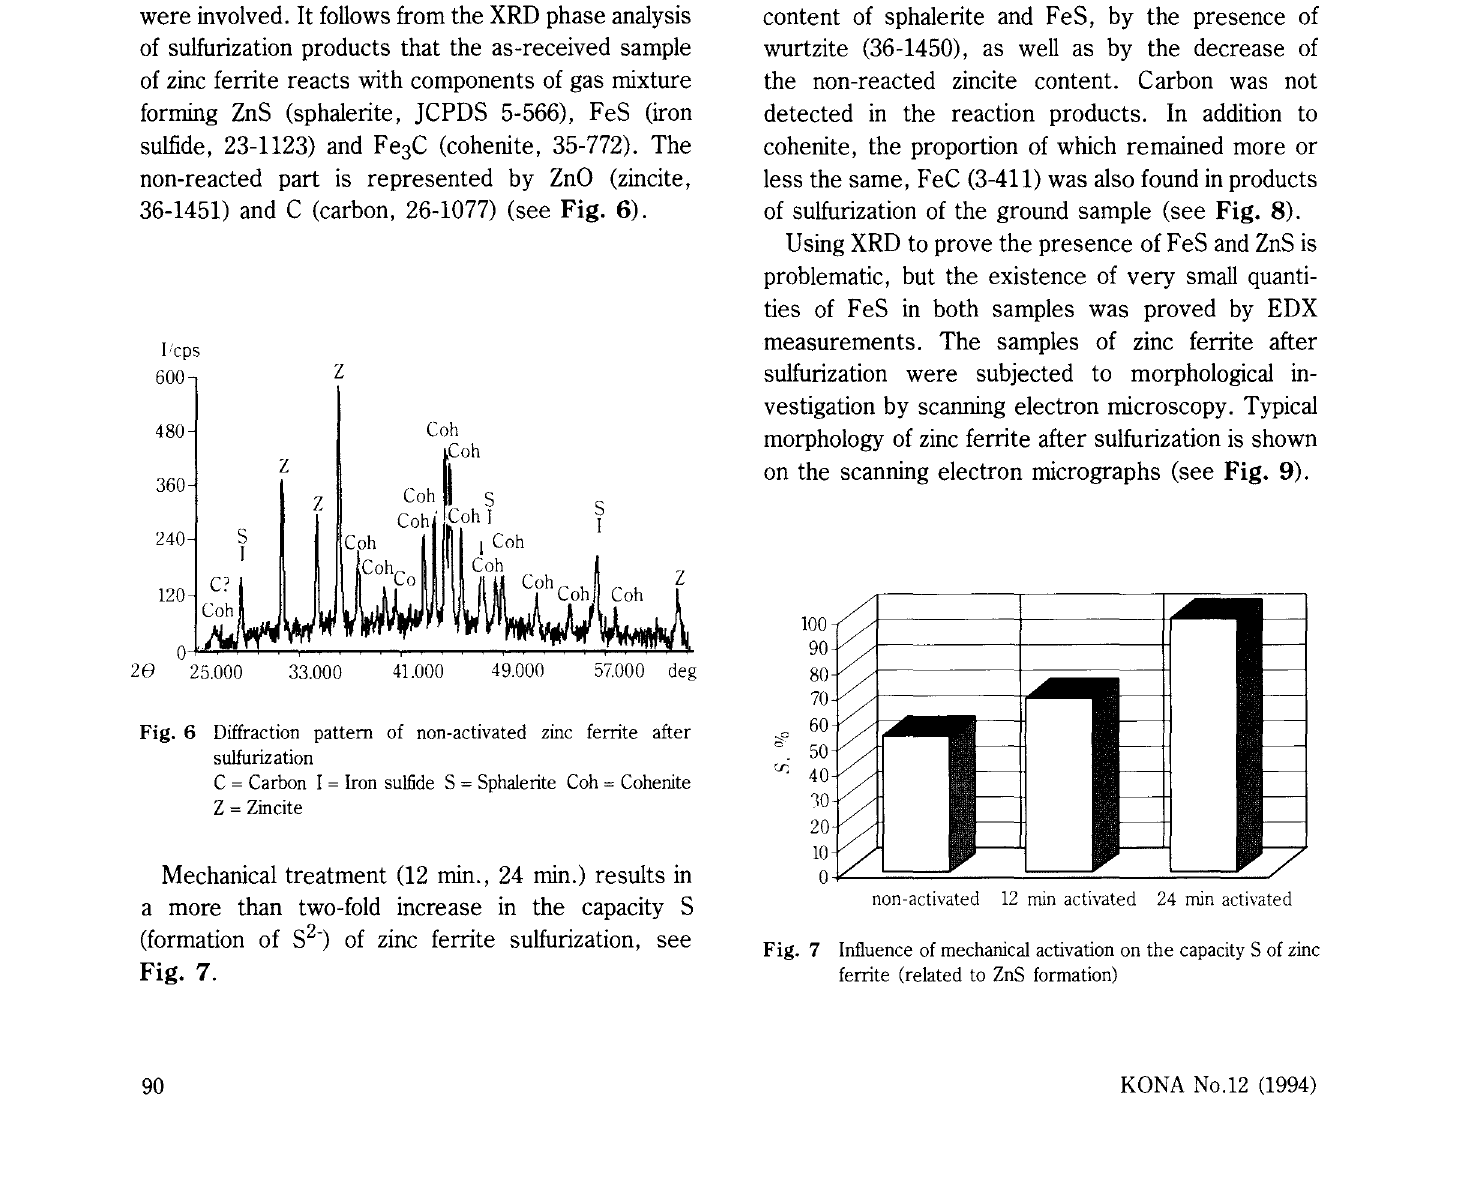
Fig. 7 Influence of mechanical activation on the capacity S of zinc ferrite (related to ZnS